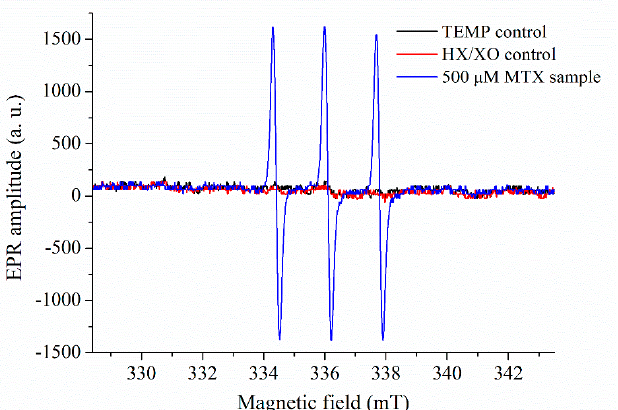
Figure 6. EPR spectra of the controls compared to the sample containing 500 µM MTX. All spectra were recorded 3 h after sample preparation.